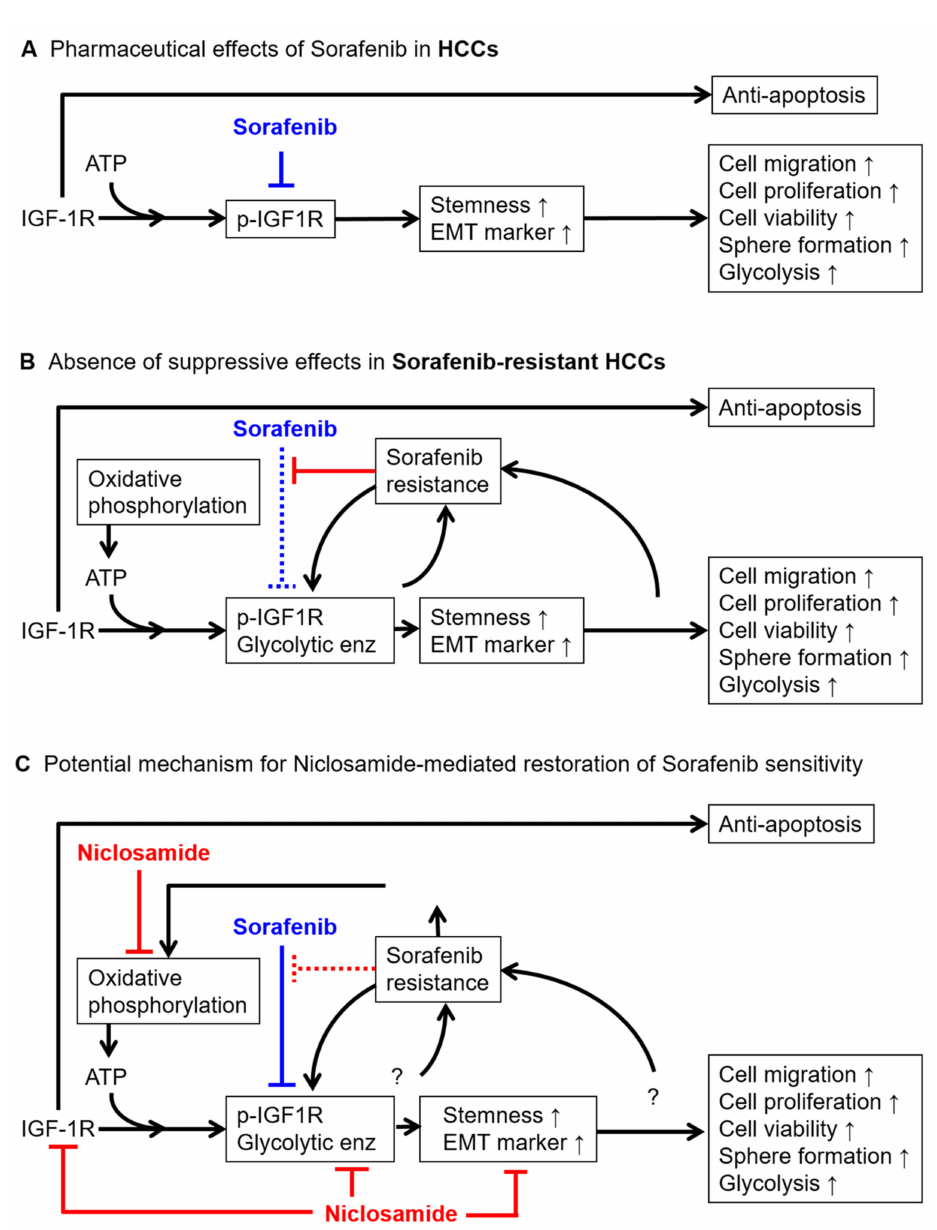
Figure 6. Model for potential niclosamide-mediated restoration of sorafenib sensitivity in sorafenib- resistant HCC cells. ( A ) Pharmaceutical effects of sorafenib in HCC cells. ( B ) Absence of suppressive effects in sorafenib-resistant HCC cells. ( C ) Potential mechanism for niclosamide-mediated restoration of sorafenib sensitivity in sorafenib-resistant HCC